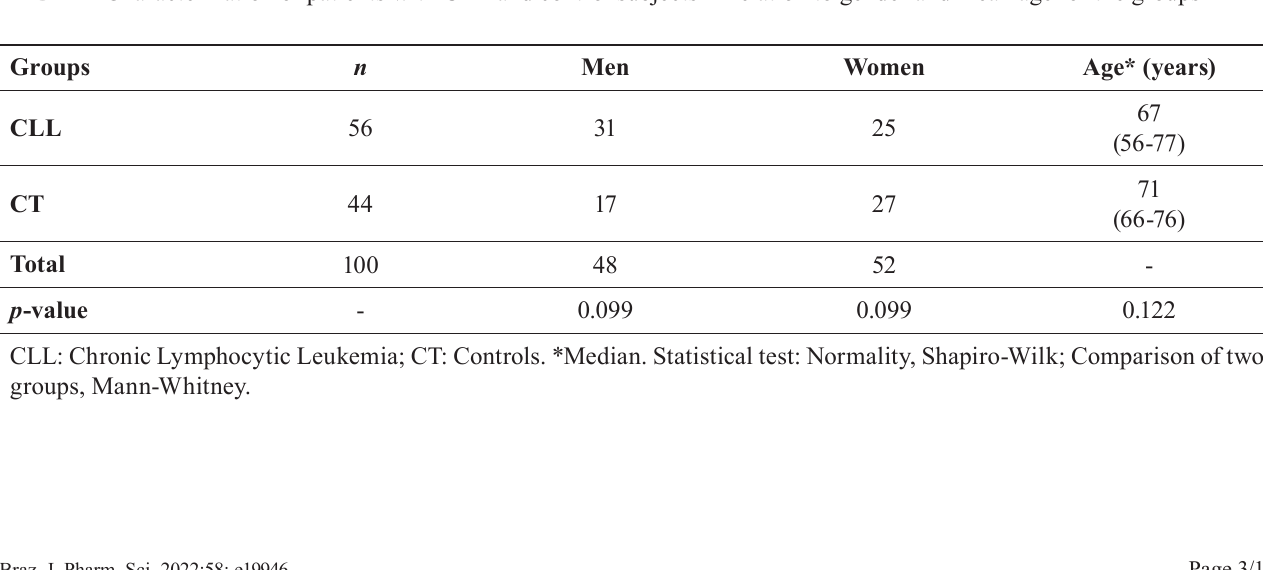
TABLE I - C haracterization of patients with CLL and control subjects in relation to gender and mean age for the groups Groups